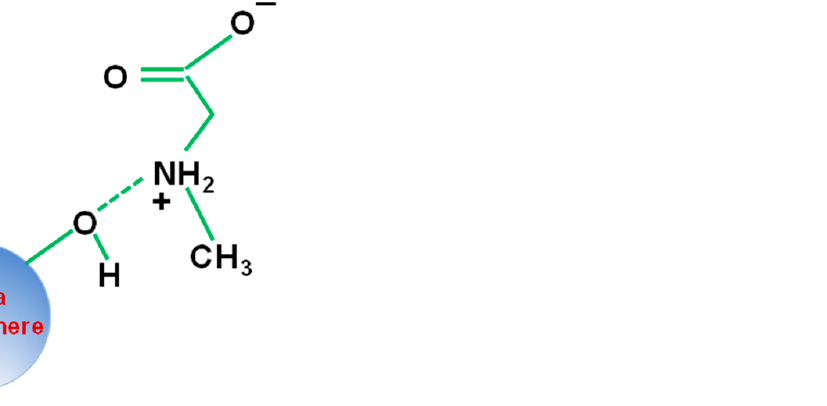
Figure 1. Schematic illustration of the attachment of the sarcosine cancer biomarker with silica nanoparticles.